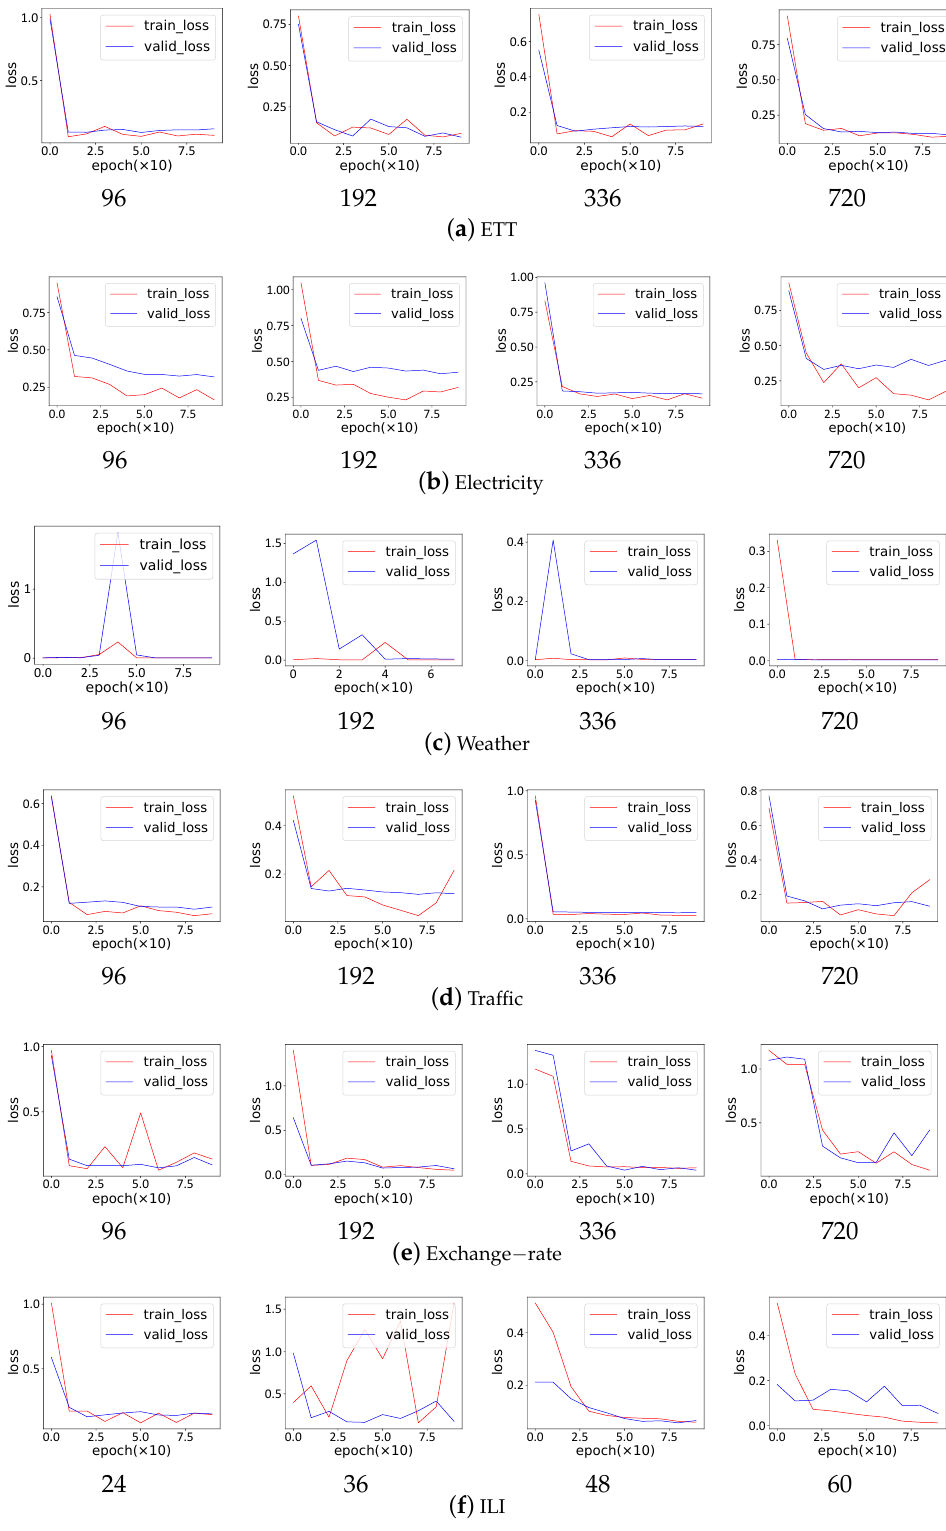
Figure 6. The convergence process of SCACD. The abscissa represents the number of epochs, and the ordinate represents the